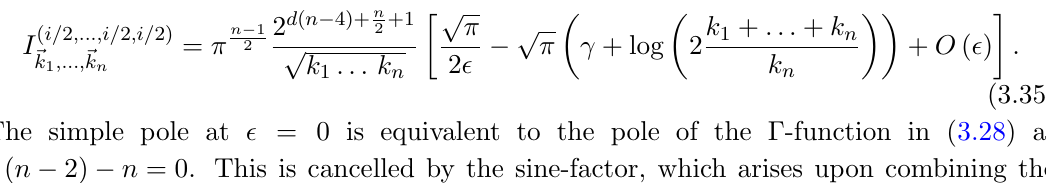
JHEP01(2020)090